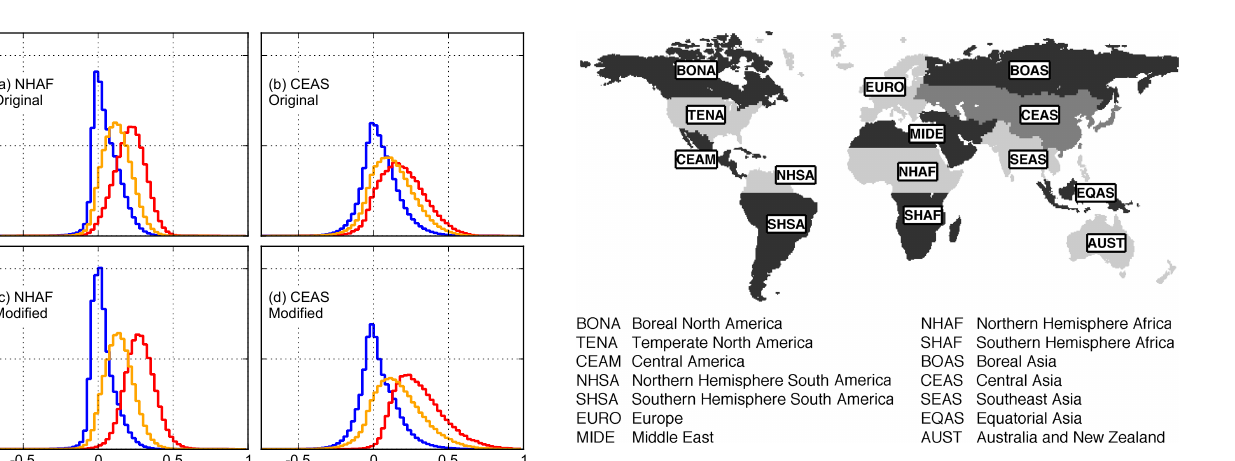
Figure 3. Map of the 14 regions used in this study, after Giglio et al. (2006) and van der Werf et al.